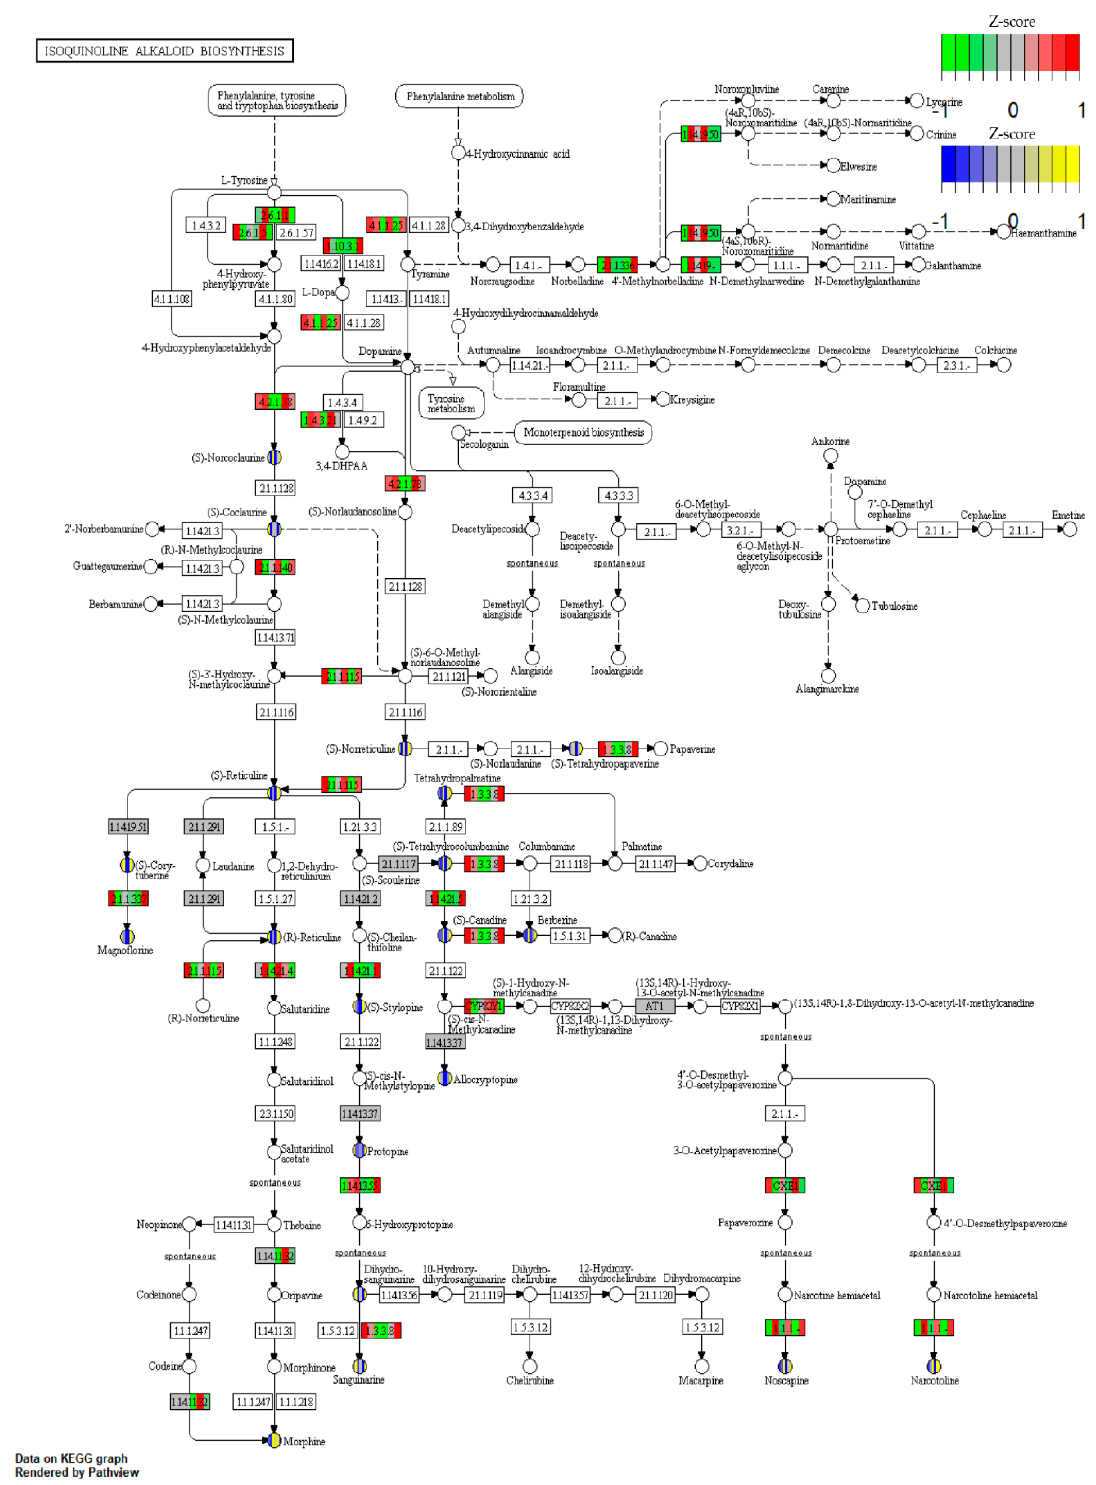
Figure 6. Overview of the isoquinoline alkaloid biosynthesis pathway (KEGG Pathway ID: map00950). The map is marked with the available transcripts and metabolites along with their differential expression patterns using Pathview. The color codes for the transcript differential expression values were in green and red, and for the metabolite, differential quantity values were in blue and yellow color. The sample order is RS (30,60,90), and NW (30,60,90).